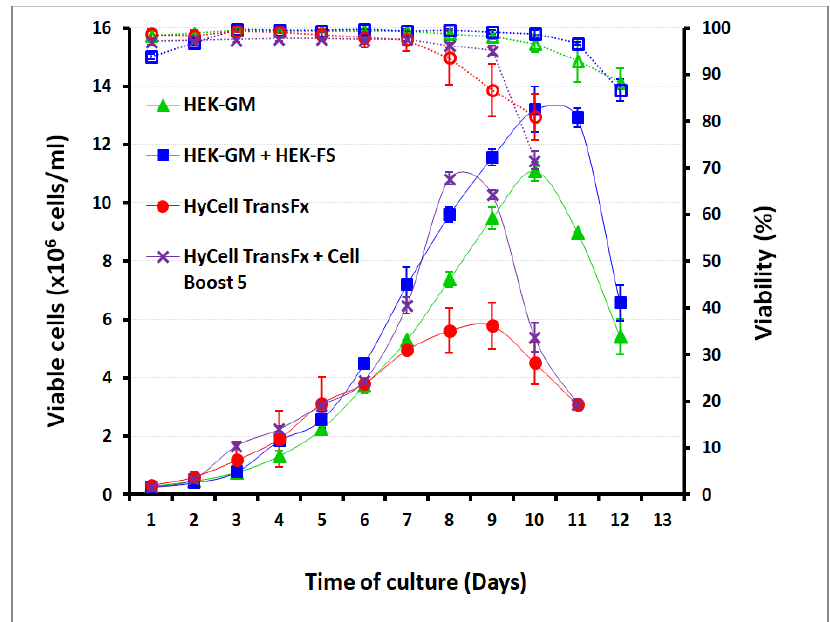
Figure 2. Effect of two different culture media and feeding supplements on HEK293SF cell density and viability (in percent) in shake flask experiments: HyCell TransFx-H media (Hyclone